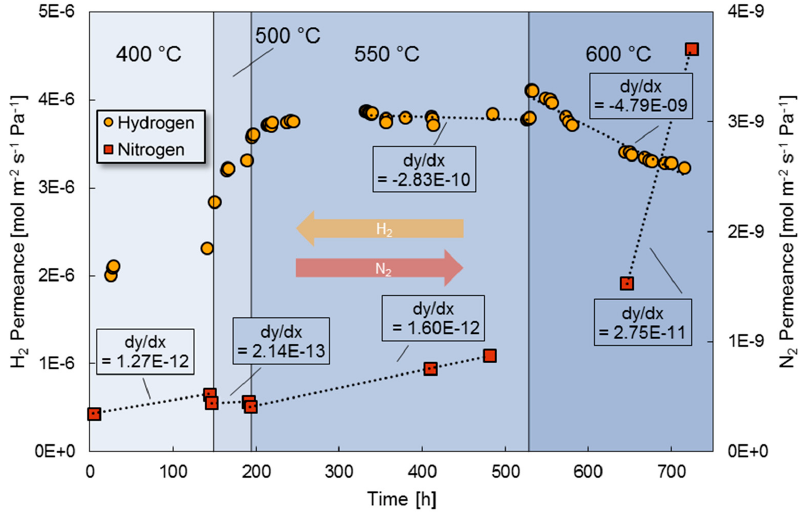
Figure 8. Effect of temperature on the long-term hydrogen and nitrogen permeance of membrane 4a.